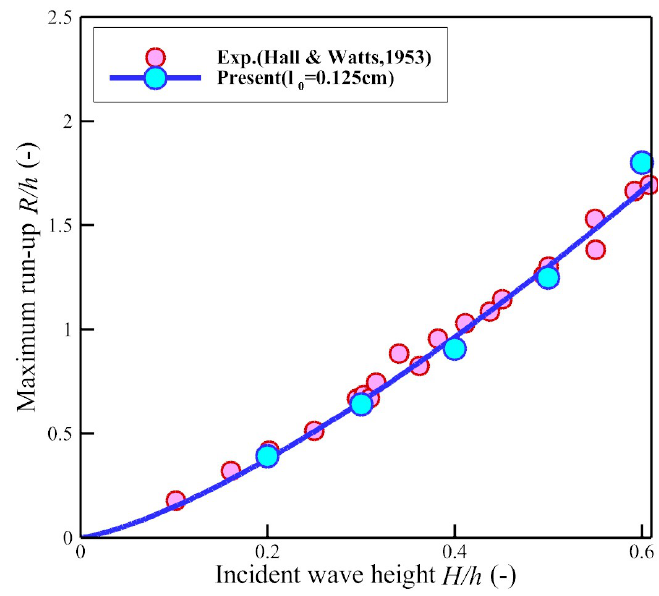
Figure 9. Comparison of the maximum run-up (constant slope angle = 90 ◦ ).